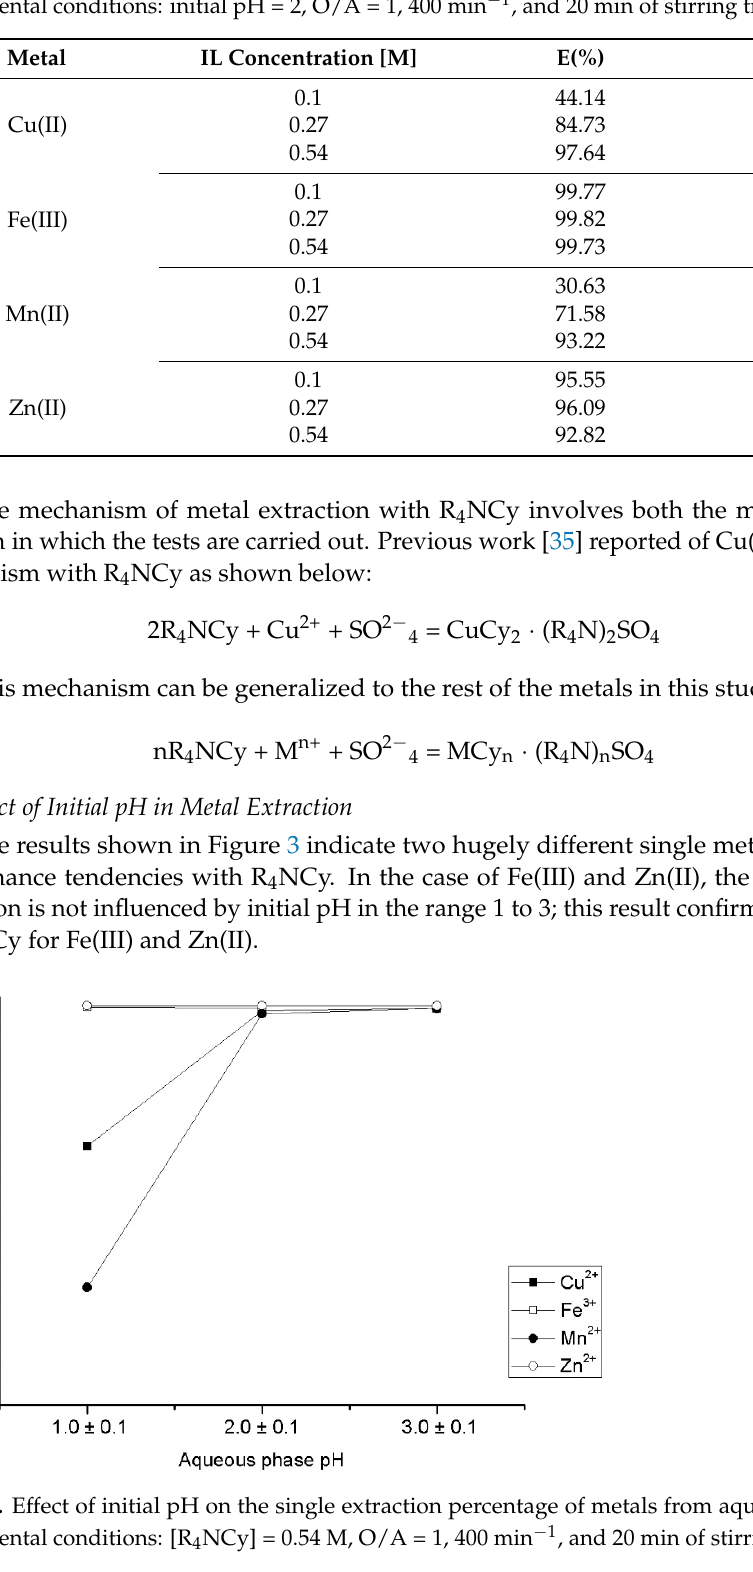
Table 2. Effect concentration of R 4 NCy on extraction efficiency and distribution ratio of the species.